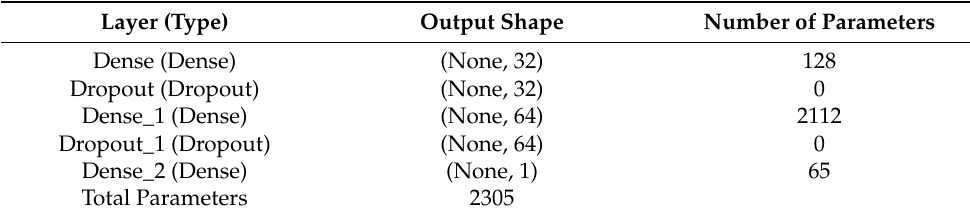
Figure 13. ANN architecture and model summary. Table 2. Model Summary.